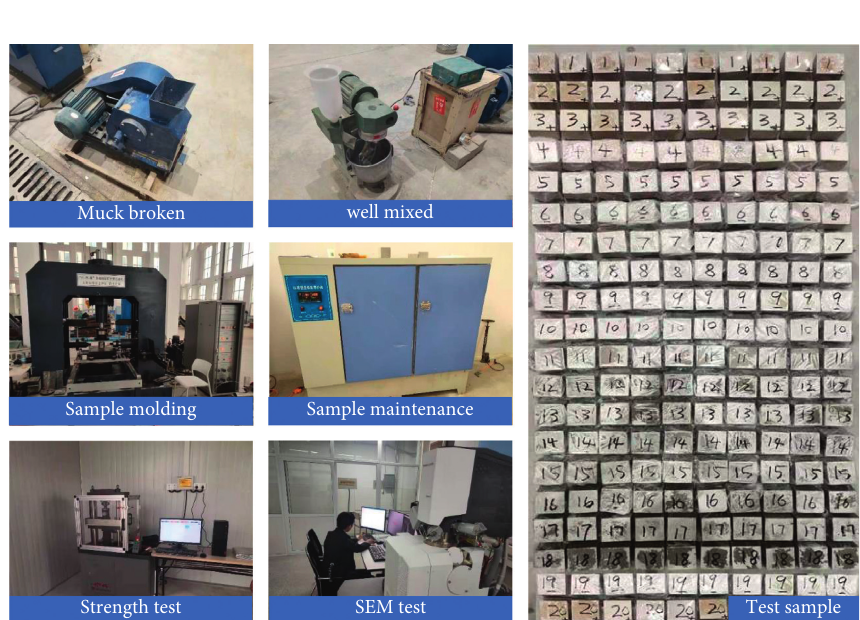
Figure 2: Related test equipment and test